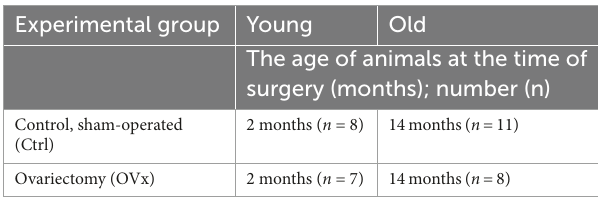
TABLE 1 The distribution of animals in the experimental